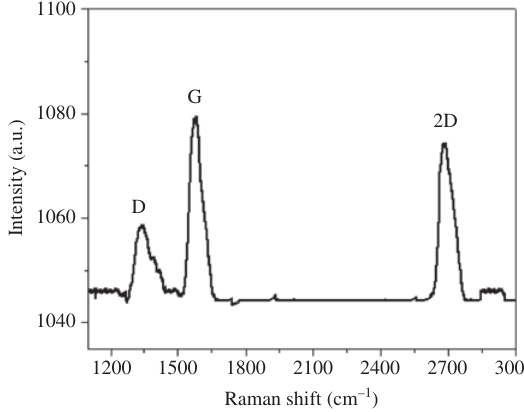
Figure 9: Raman spectra (excited by 512 nm laser) of